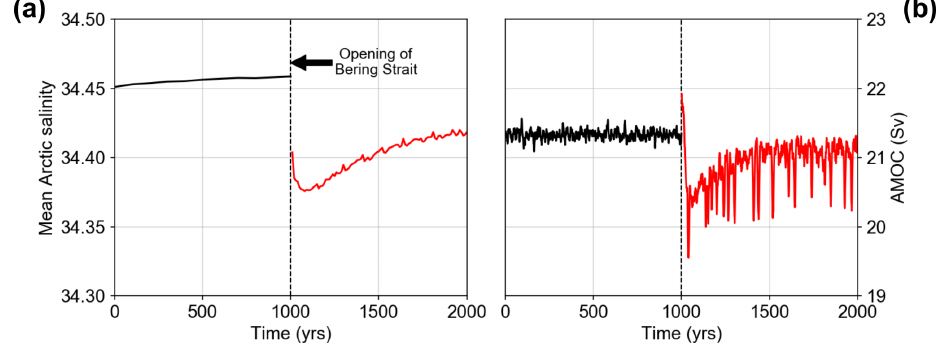
Figure 8. (a) Evolution of mean Arctic salinity (integrated over all water depths) and (b) AMOC strength with opening of the Bering Strait at year 1000. The mean meridional advection through the Bering Strait is